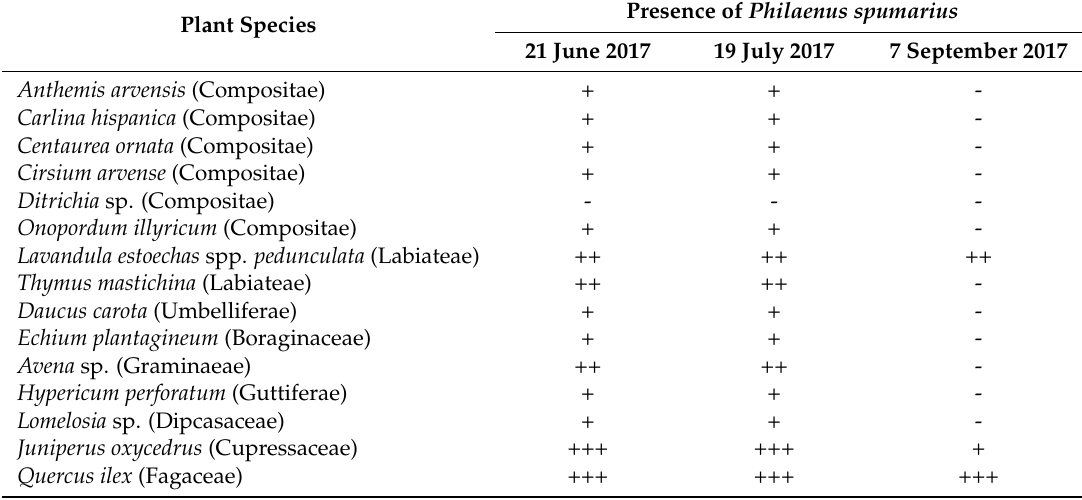
Table 2. Host plants of P. spumarius in summer in Colmenar Viejo (2017): (-) absent, (+) low presence, (++) moderate presence, and (+++) high